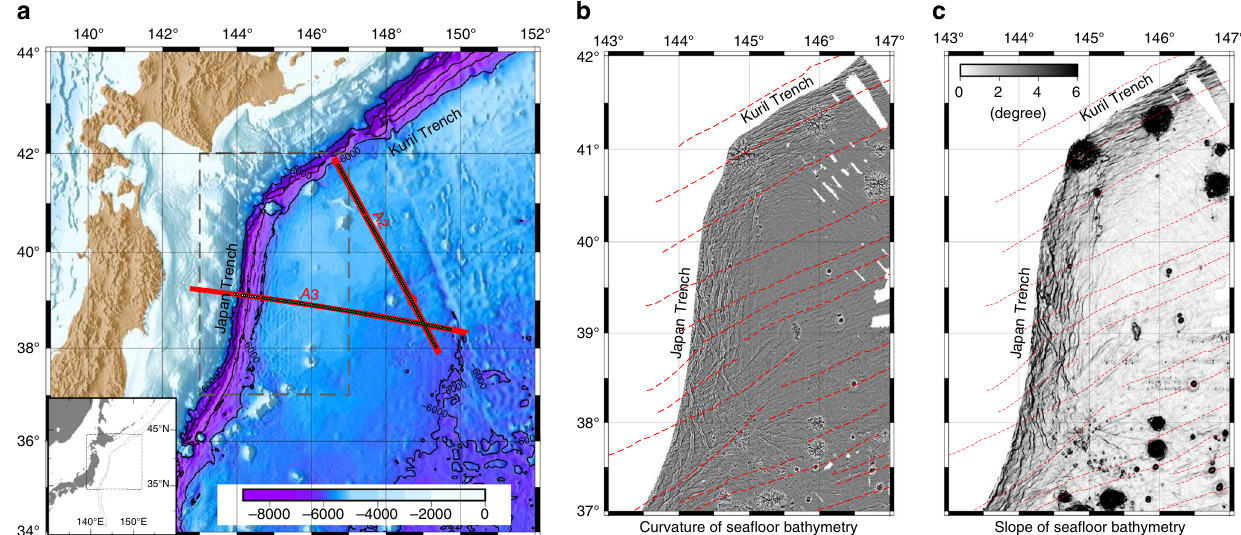
Fig. 1 Study area. a Bathymetric map of the north-western Paci fi c margin off Japan around the junction of Kuril and Japan trenches (location in inset). Solid red lines A2 and A3 are seismic survey lines. White circles represent OBSs located in the vicinity of the Japan Trench axis, and green circles represent other OBSs. No OBSs were deployed in the vicinity of the Kuril Trench axis. b Curvature (Laplacian) of the sea fl oor topography in the outer trench area. c Slope gradient of the sea fl oor in the outer trench area. Dashed red lines in b , c are magnetic anomaly lineations